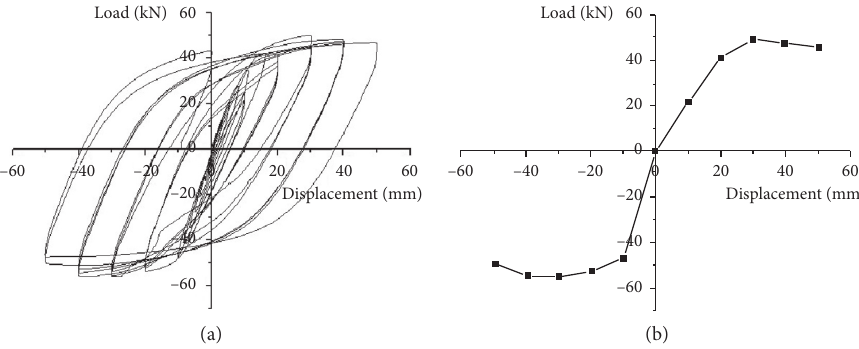
Figure 11: Hysteretic curve and envelope curve for SRC-3.